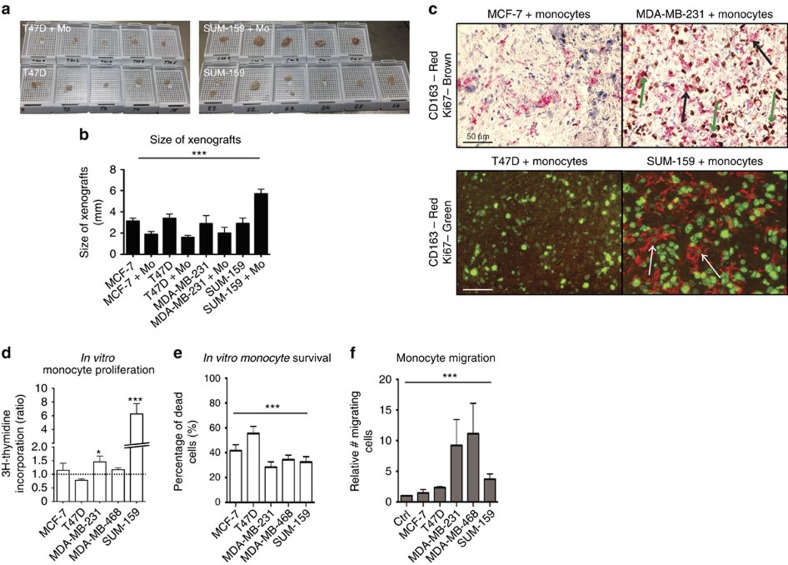
Characterization of primary monocytes in TNBC cultures.Primary human monocytes show increased proliferation, survival and migration in a TNBC/monocyte environment than in a Luminal A/monocyte context. (a,b) The size of the xenografts differed between groups. Co-transplantation of monocytes generally decreased the tumour size slightly (b) except in the TN SUM-159/monocyte group, co-transplantation of monocytes (SUM-159+Mo) increased tumour growth significantly (a,b). ***=P<0.001 ANOVA. N=5. (c) Myeloid cells proliferate in vivo. Upper panel: Double staining IHC of CD163 and Ki67 in xenografts from MCF-7/monocytes co-transplant (left) or MDA-MB-231/monocyte co-transplants (right) tumours as indicated. Black arrows show single staining with only CD163 and green arrows show double staining. Lower panel: Double staining immunofluorescence of CD163 and Ki67 in xenografts from T47D/monocytes co-transplant (left) or SUM-159/monocyte co-transplants (right) tumours as indicated. White arrows show CD163+ cells with a clear nuclear Ki67 staining. (d) Proliferation of primary human monocyte cultured in control medium or in conditioned medium from different cell lines, was assessed using the thymidine incorporation assay. *=P<0.05 ANOVA. N=14. (e) Survival of isolated human primary monocytes in breast cancer cell conditioned medium, grown for 7 days, was assessed. Annexin V staining was performed to analyse the total content of apoptotic/dead cells. ***=P<0.001. ANOVA. N=5. Error bars indicate s.e.m. (f) Boyden chamber migration assay of primary human monocytes migrating towards control medium or MCF-7, T47D, MDA-MB-231, MDA-MB-468 or SUM-159 breast cancer cell conditioned medium. ***=P<0.001 ANOVA. N=5. Error bars indicate s.e.m.